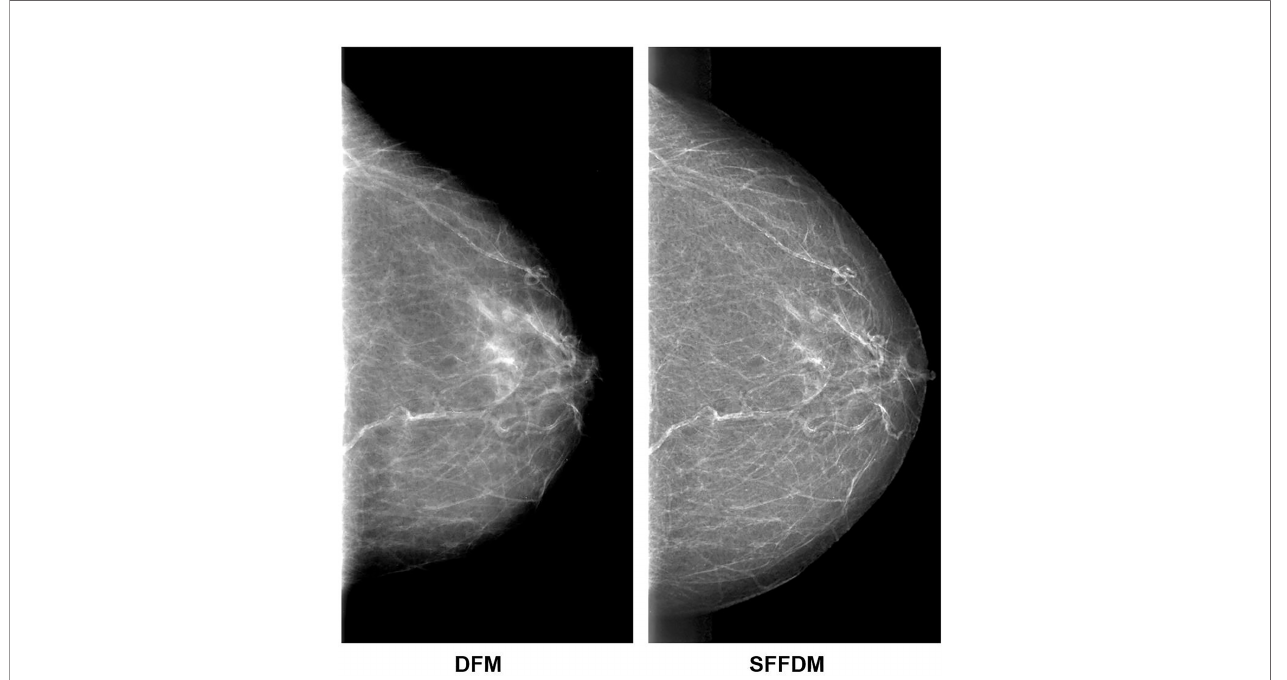
FIGURE 4 | Visual comparison between DFM and SFFDM. Breast tissues are enhanced in SFFDM compared to DFM. Additionally, the breast region boundary was barely visible in the left DFM while the boundary was complete and clear in the right SFFDM. This clear boundary helped us locate the nipple position easily.